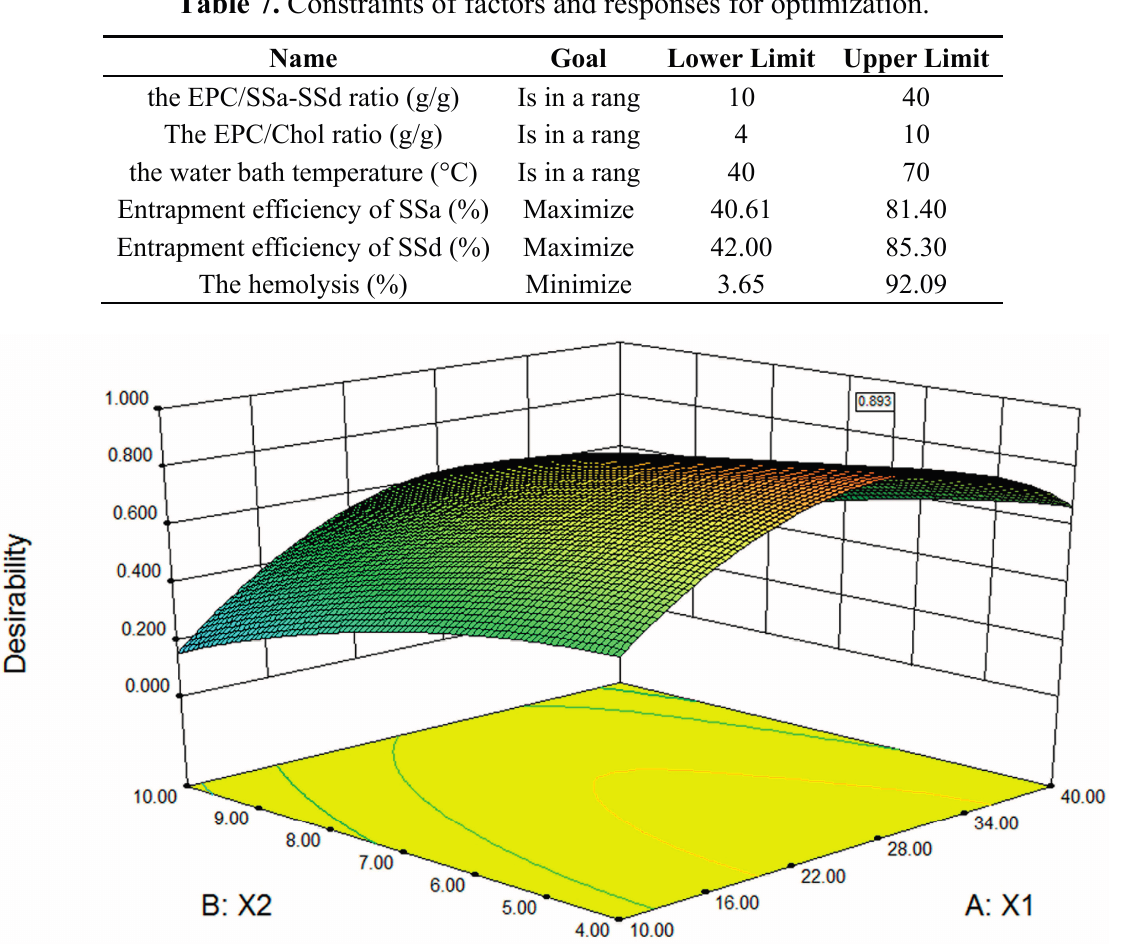
Figure 3. Fitted surface for the desirability as a function of the EPC/SSa-SSd ratio (X 1 ) and the EPC/Chol ratio (X 2 ). Water bath temperature = 49.96